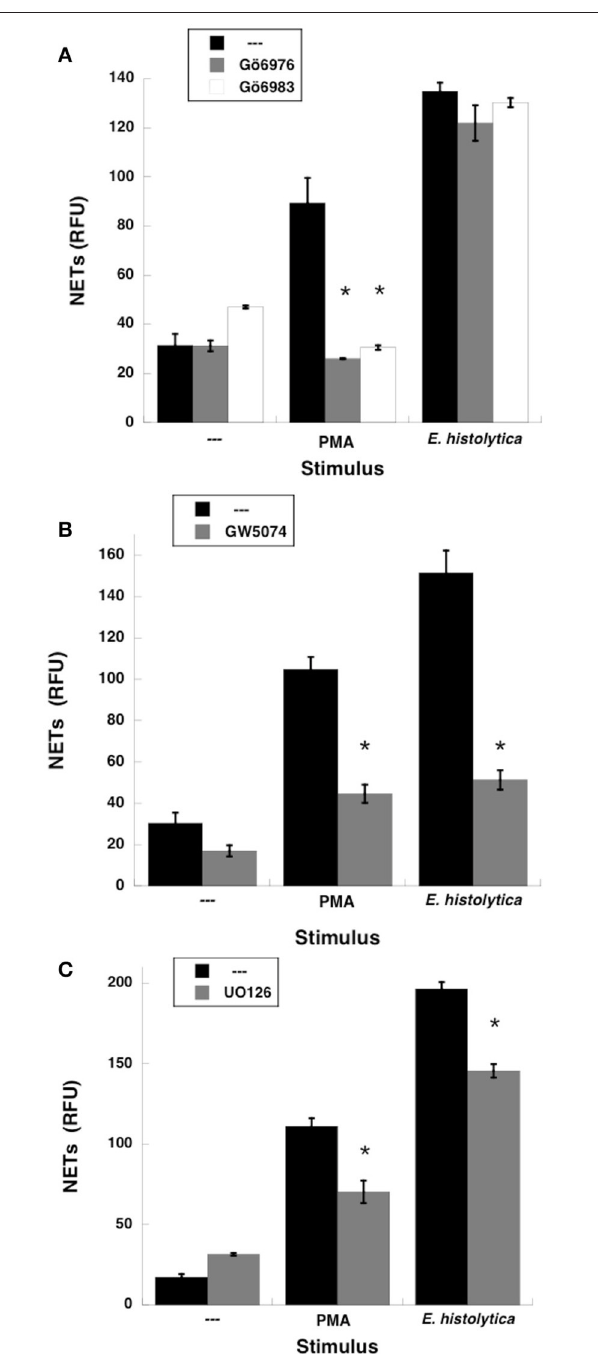
FIGURE 4 | Entamoeba histolytica- induced NETs formation is dependent on Raf and MEK, but not PKC . Human neutrophils were left untreated (—), stimulated with 20 nM phorbol 12-myristate 13-acetate (PMA), or with E. histolytica trophozoites. PMN were previously treated with solvent alone (—) or (A) with the PKC inhibitors Gö6976 (1 µ M), or Gö6983 (1 µ M); or (B) with the Raf inhibitor GW5074 (100 µ M); or (C) with the MEK inhibitor UO126 (75 µ M). The relative amount of NETs was estimated from SYTOX ® Green fluorescence in relative fluorescent units (RFU) at 4h after stimulation. Data are mean ± SEM of 3 experiments. Asterisks denote conditions that are statistically different from control ( p < 0.001).